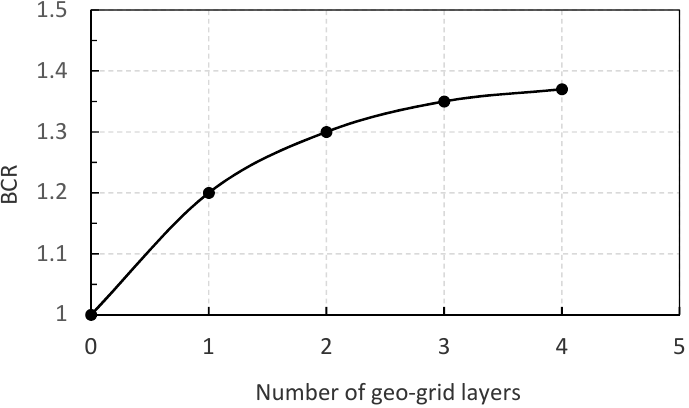
Figure 6. Increase of BCR is limited when more geogrid layers were used. Table 3. The optimum depth to lay the top geogrid layer.